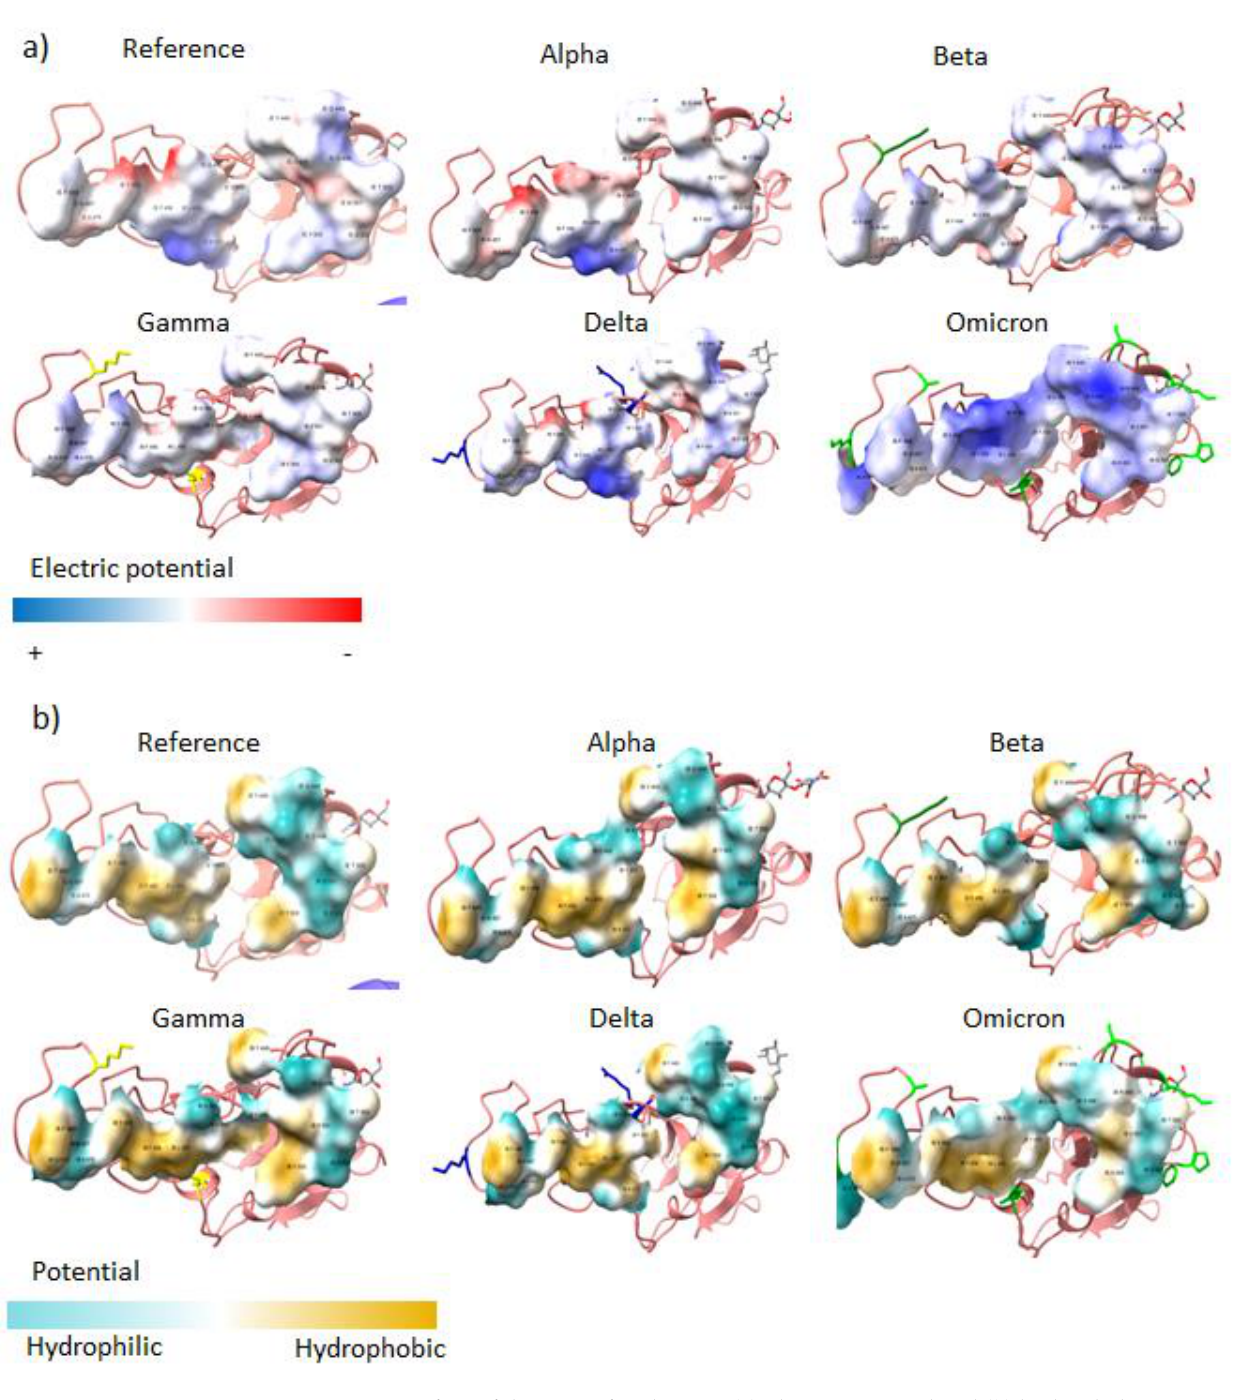
Figure 2. Interface of the RBD of each VOC. ( a ) Electric potential and ( b ) hydrophobic potential of the interface of the RBDs of each VOC.